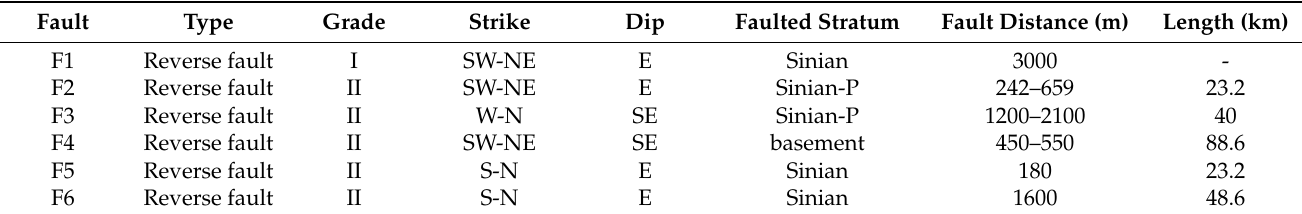
Table 5. Main fault elements in the study